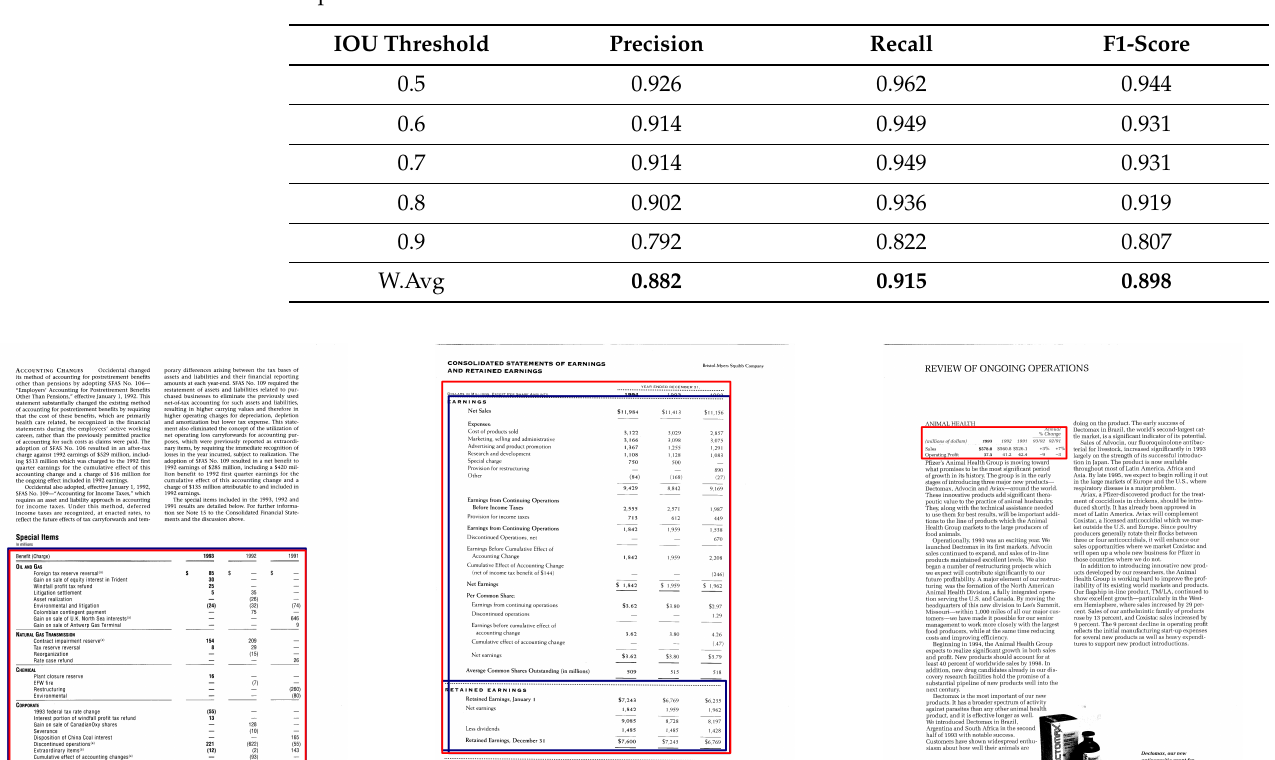
Table 5. HybridTabNet results on UNLV dataset. W.Avg denotes the weighted-average of the respective measure on the IoU threshold.